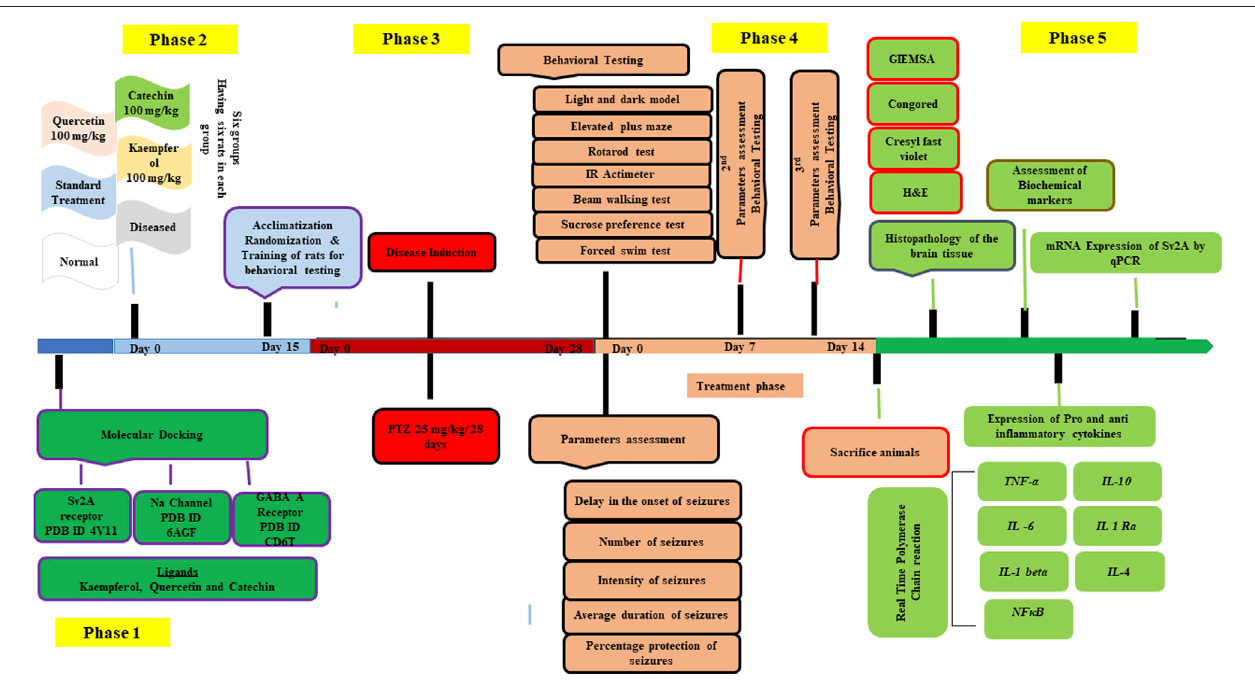
FIGURE 1 | Showing the study